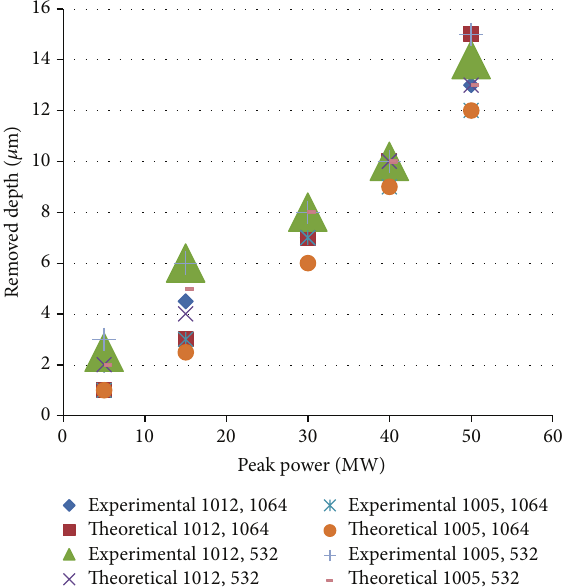
Figure 1: Removed depth at different peak powers, wavelengths of 1064 and 532, and PRR of 4 Hz for AISI1012 and AISI1005.